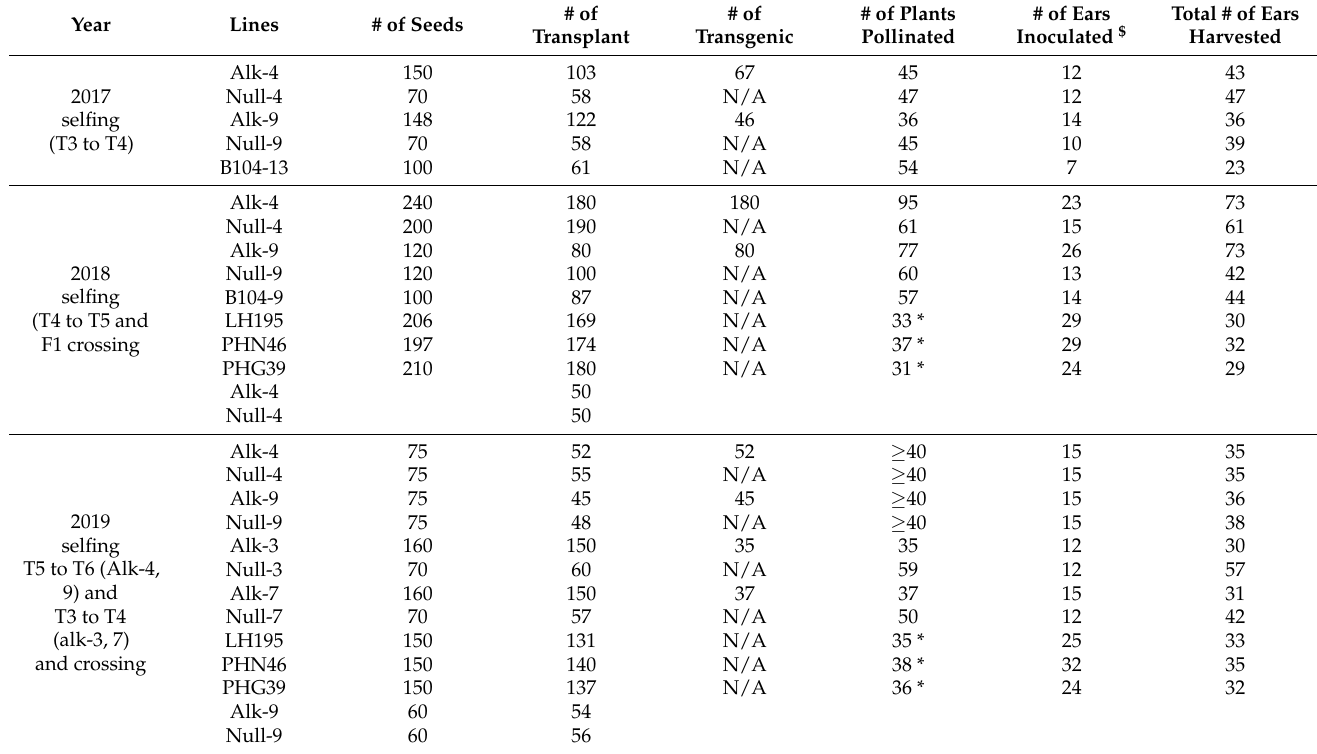
Table 1. Information on the self-pollination of Alk lines from 2017 to 2019 and crosses produced with three elite inbred lines in 2018 and